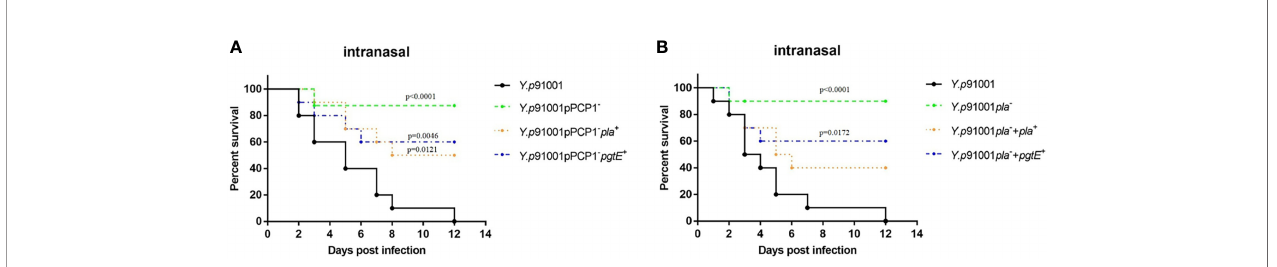
FIGURE 4 | Mice infected intranasally with PgtE-expressin g Y. pestis are more susceptible to death compared with pPCP1 plasmid cured and pla-deleted Y. pestis . (A) Y.p 91001, Y.p 91001pPCP1 - , Y.p 91001 pPCP1 - pla + and Y.p 91001 pPCP1 - pgtE + were used to challenge mice via the intranasal route. The mice were monitored for 12 days, and the log-rank test was performed. (B) Y.p 91001, Y.p 91001 pla -, Y.p 91001 pla - + pla + , Y.p 91001 pla - + pgtE + were used to challenge mice via the intranasal route. The data shown were obtained from three